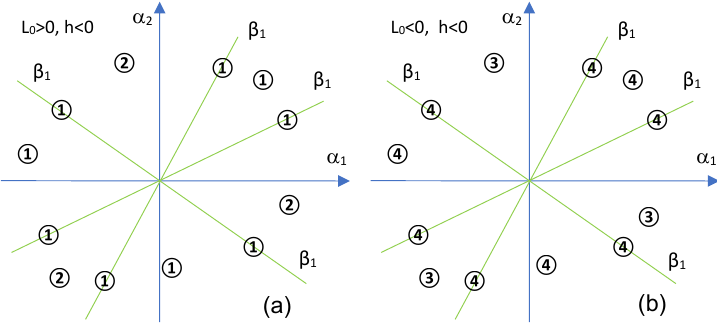
Figure 5. Bifurcation diagrams in the Case I when p < 0, r < 0, and ∆ 2 > 0: ( a ) L 0 > 0, h < 0; ( b ) L 0 < 0, h < 0.